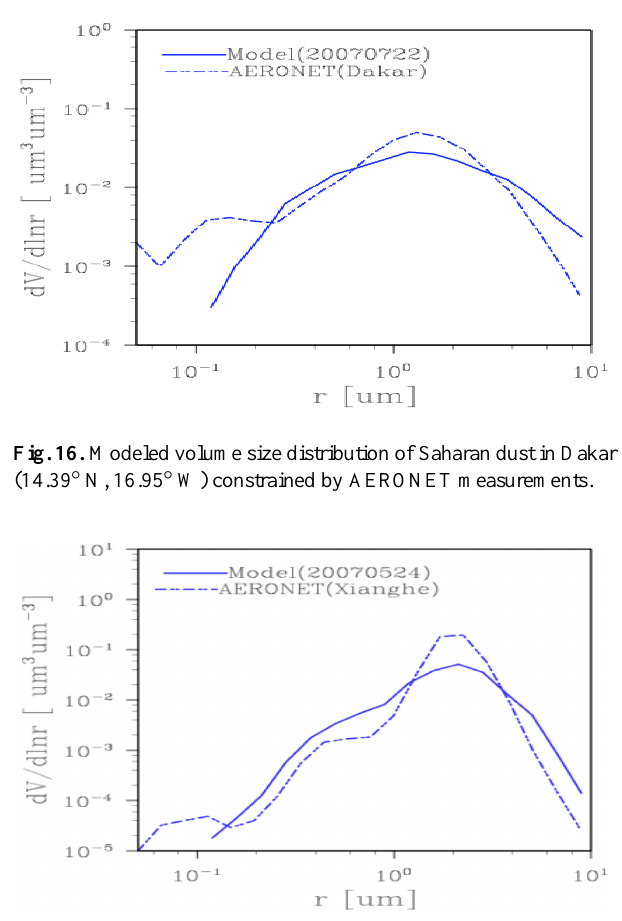
Fig. 17. Modeled volume size distribution of Asian dust in Xianghe (39.75 ◦ N, 116.96 ◦ E) constrained by AERONET